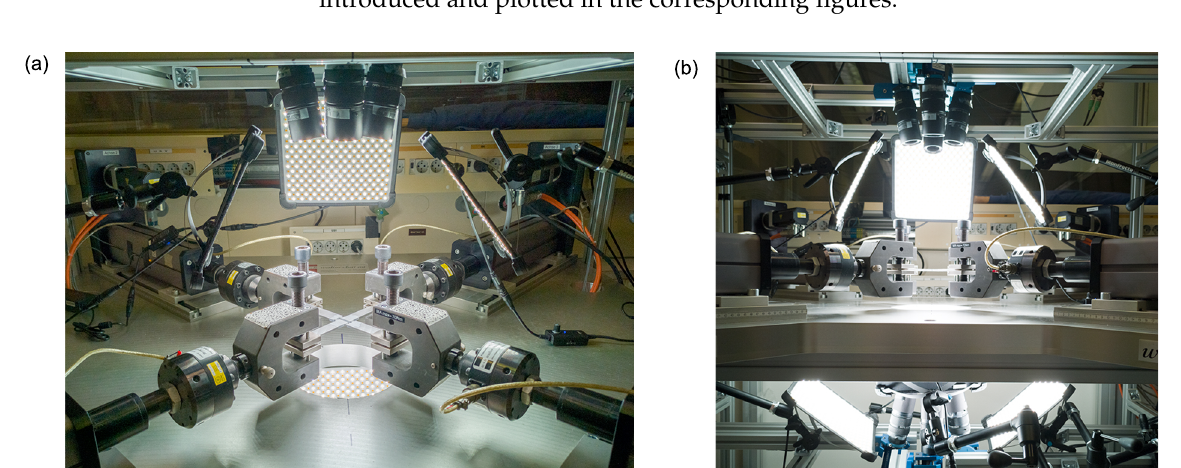
Figure 1. ( a ) Biaxial test machine, ( b ) lighting system and camera